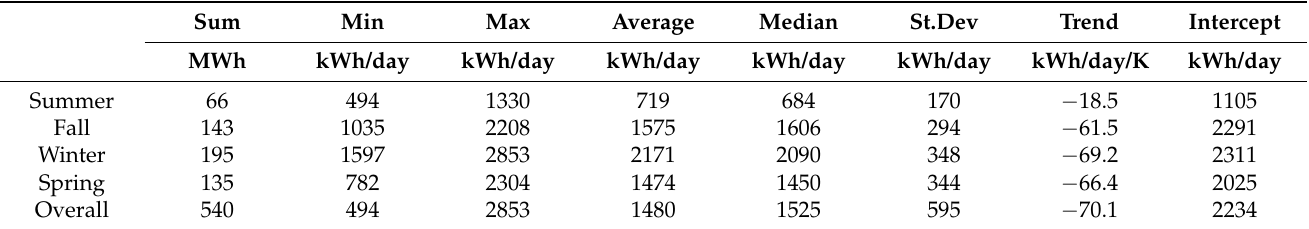
Table 3. Summary table based on daily energy use of Testbed EM.